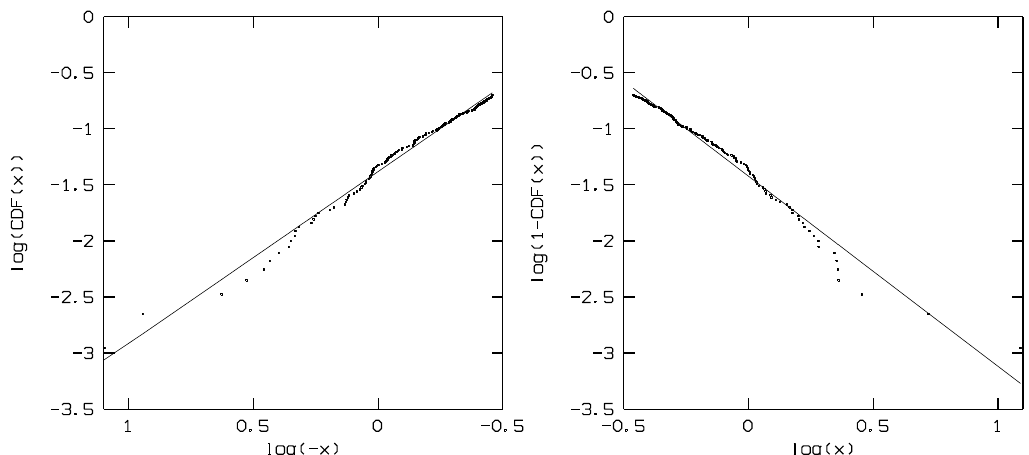
Figure 5. The left plot is the double logarithmic graph of the CDF of the negative 20% of the data set of X i and the solid line represents the best fitting result for the negative 20% of the data set of X i . The right plot is the double logarithmic graph of the CDF of the positive 20% of the data set of X i , and the solid line represents the best fitting result for the positive 20% of the data set of X i .